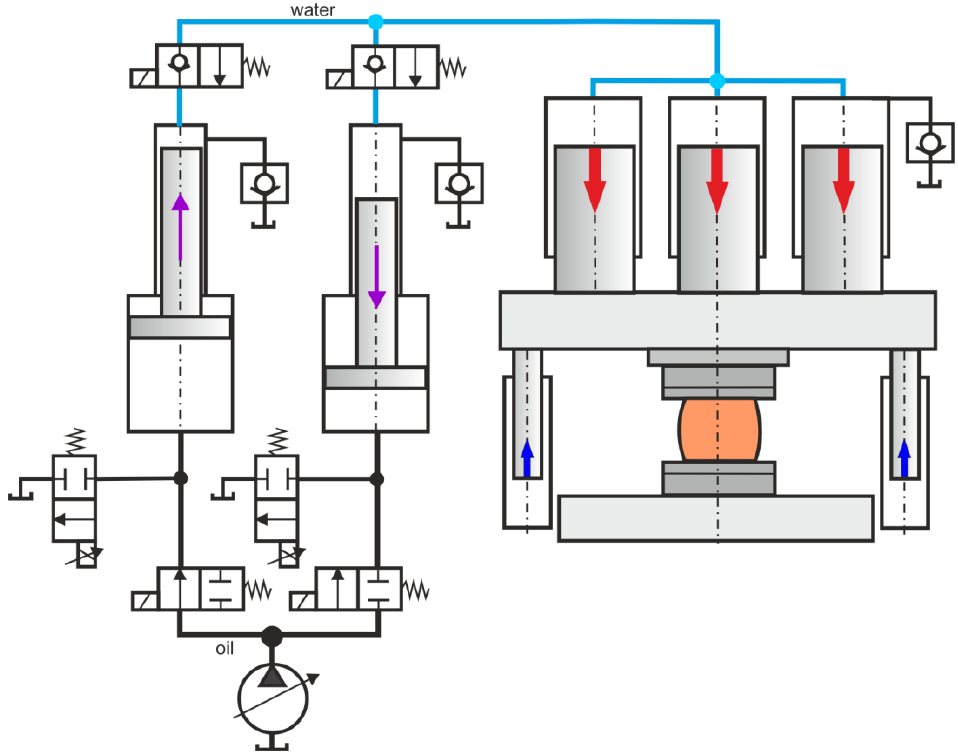
Figure 1. Diagram scheme of a hydraulic forging press with a multiplier pump system.